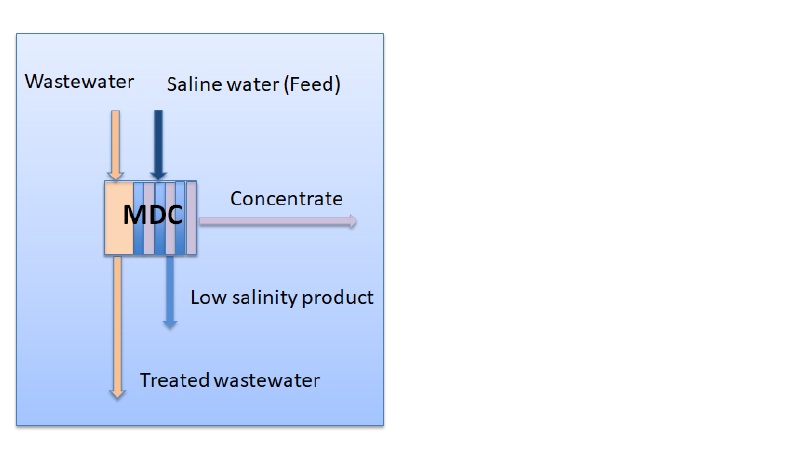
Figure 3. Conceptual diagram of a desalination process by means of a MDC.